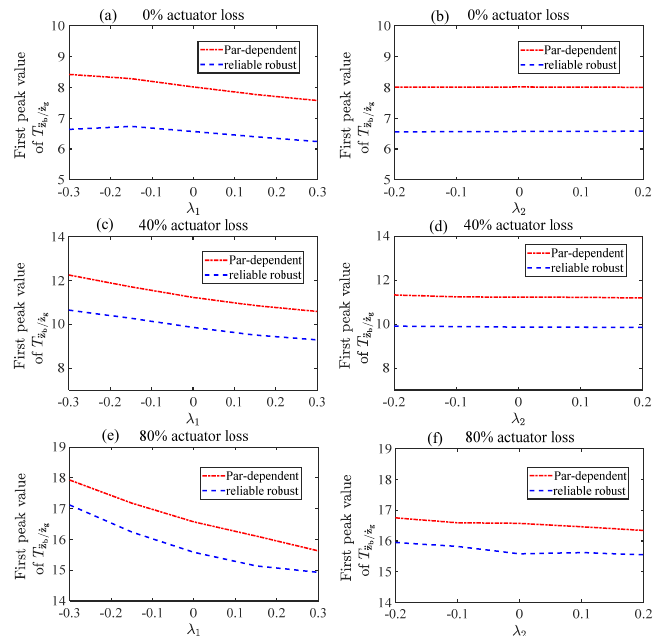
Figure 12. The first peak value of T .. with the parameter-dependent controller and the reliable z b / . z g robust controller versus the uncertain parameters λ 1 and λ 2 : ( a ) versus λ 1 under 0% actuator loss; ( b ) versus λ 2 under 0% actuator loss; ( c ) versus λ 1 under 40% actuator loss; ( d ) versus λ 2 under 40% actuator loss; ( e ) versus λ 1 under 80% actuator loss; ( f ) versus λ 2 under 80% actuator loss.